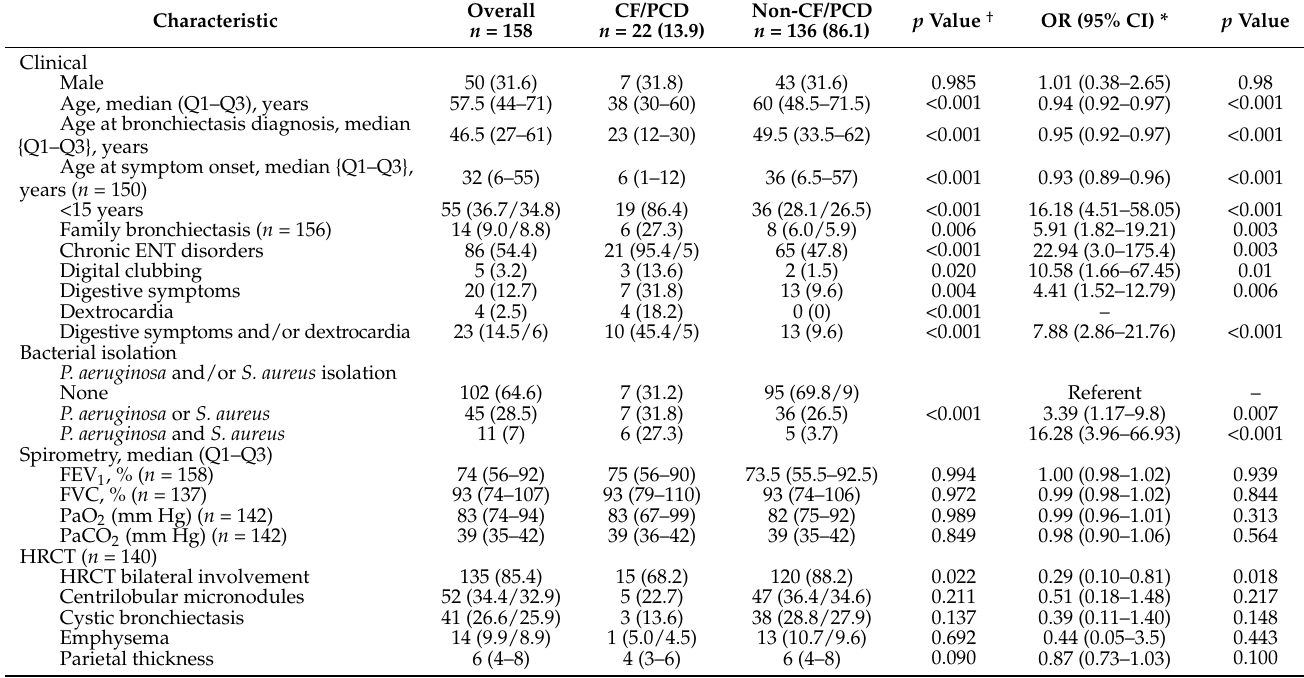
Table 1. Comparison of CF/PCD and non-CF/PCD adult patients using univariate analyses ( n = 158).